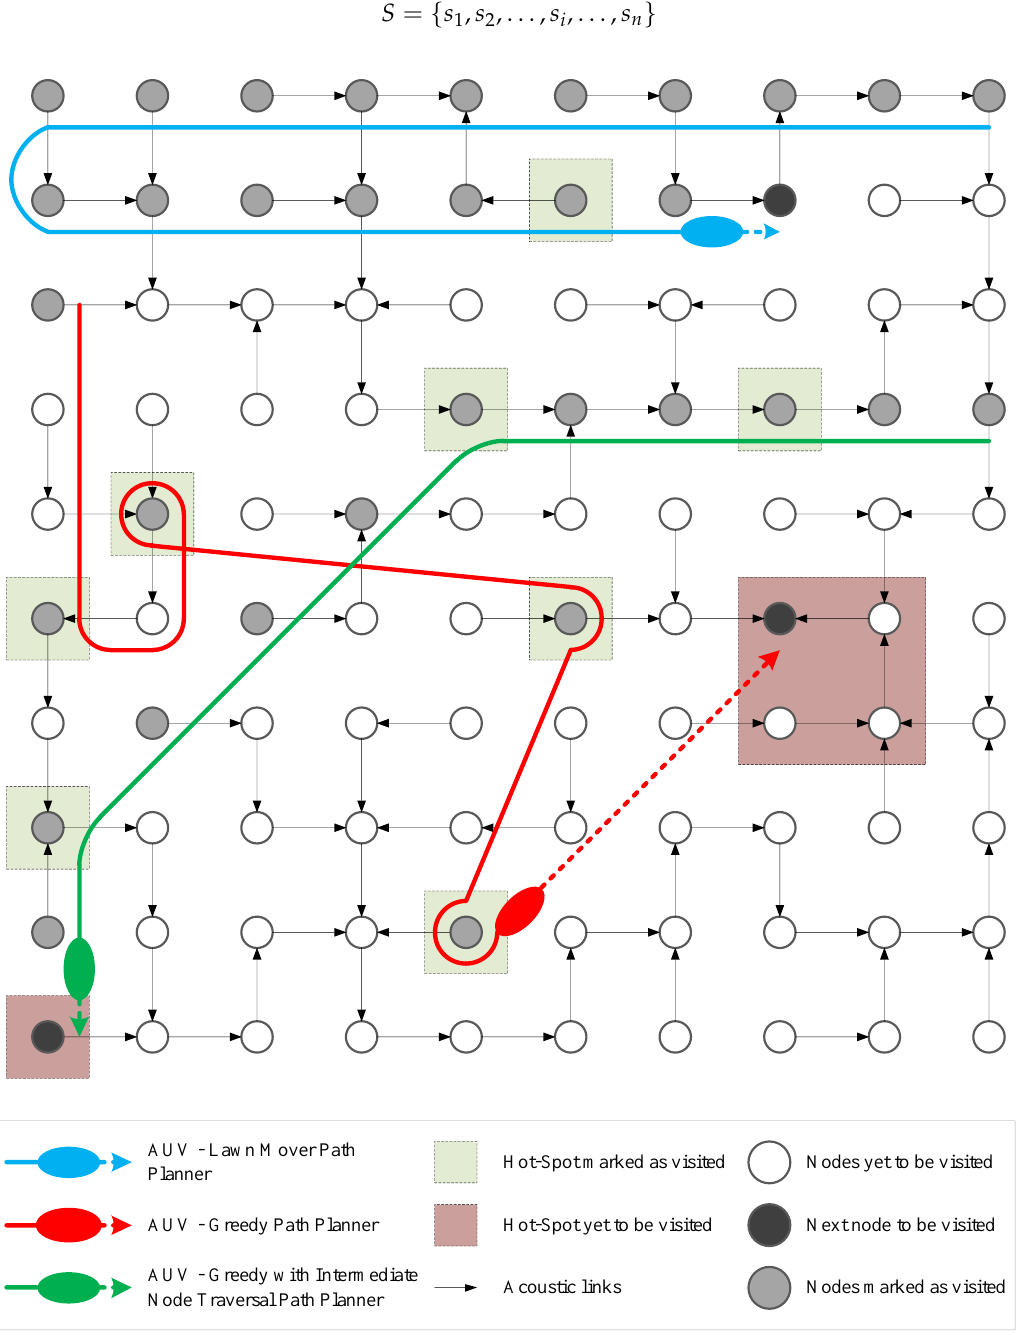
Figure 1. The UWSN mesh setting used for the simulation study. The same arrangement will be used for simulation and experimentation in the results section. The blue colored path is of the AUV that uses LPP, red of the AUV that uses GPP and green of the AUV that uses GIPP. The GPP visits one hot-spot after another. Notice how LPP stumbles upon a hot-spot, i.e., discovers it by chance. Also, observe how GIPP visits intermediate nodes in-between hot-spot